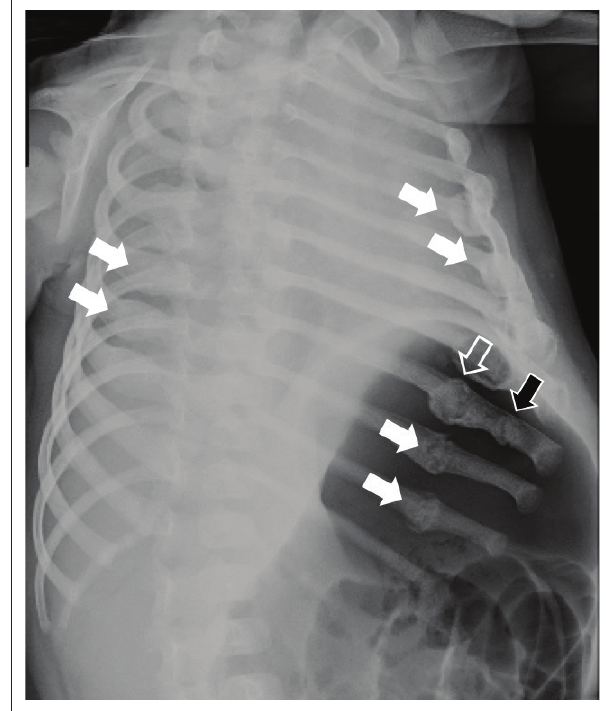
FIGURE 4: Left oblique rib view of a 3-year-old girl with multiple rib fractures (white arrows) in various stages of healing. There is a more acute fracture of the left eighth rib with minimal callus formation (black arrow) and a chronic healing second fracture in this rib with more advanced callus formation (open arrow).